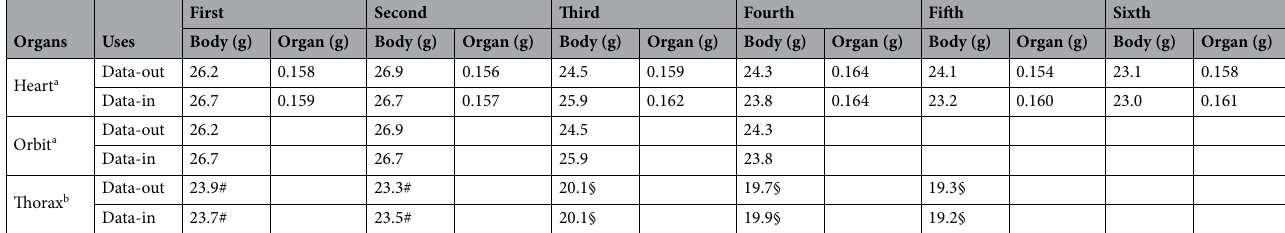
Table 3. Body or related organ weight of mice used for repeated measurements. a The organs were derived from 33-week-old male DBA/1 mice. These mice weighing 23.0–26.9 g were purchased from Janvier (Janvier Labs, France). b The organs were derived from male C57 BL/6 J mice at the age of # 10 weeks and § 6 weeks. The animals were delivered from Charles River Laboratory (Sulzfeld, Germany).